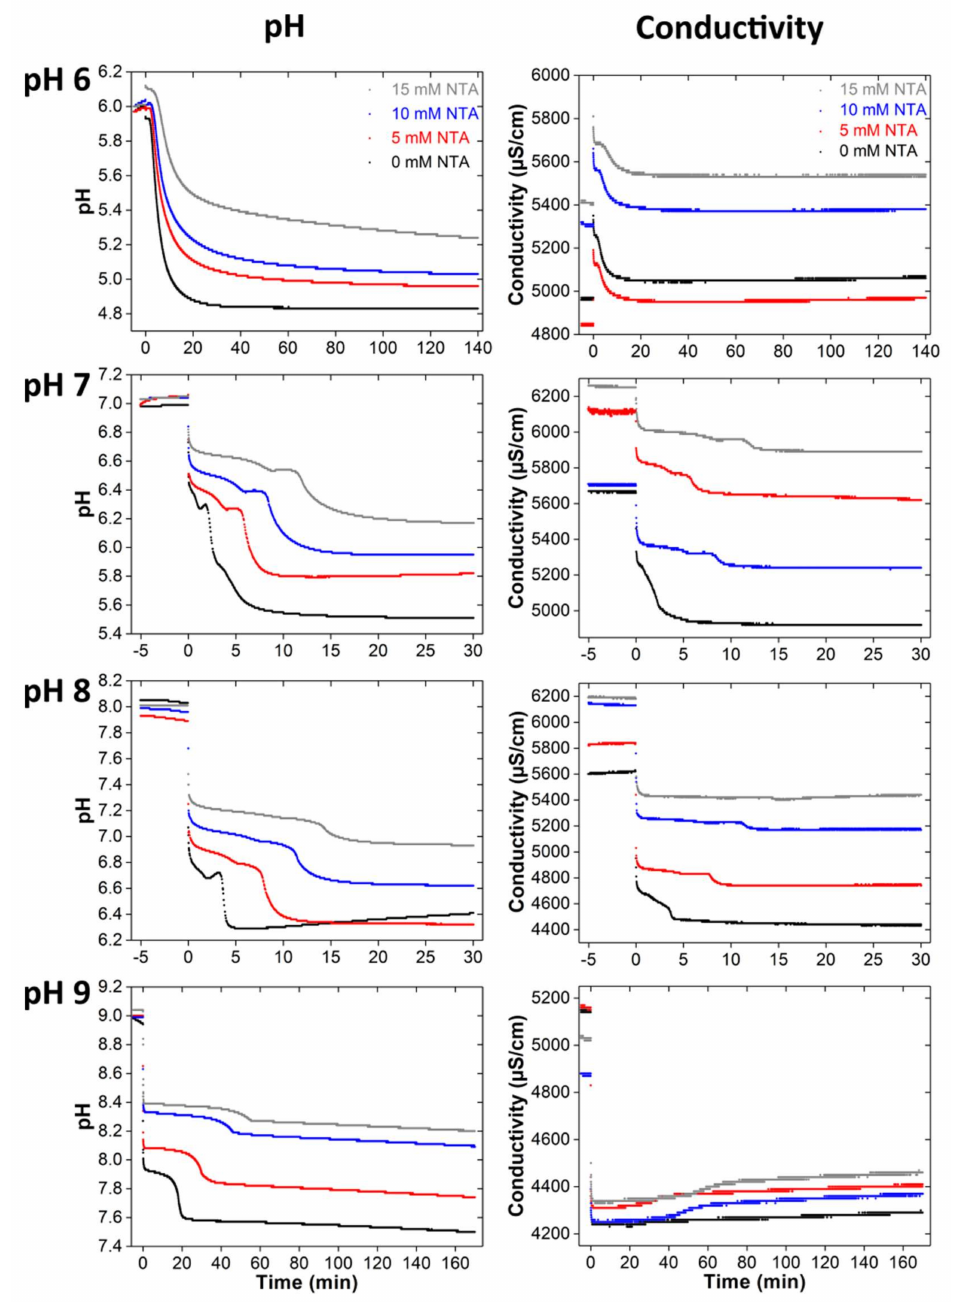
Figure 3. pH and conductivity data obtained from in situ measurements during mineralization with different NTA concentrations and starting pH. Note that the mineralization times are different: the end points (points after which no more changes in the data are observed) of the individual series of measurements were determined from longer measurements (data not shown). At the beginning of each measurement, the pH of the initial solution (40 mM calcium nitrate solution with 0, 5, 10, and 15 mM of NTA) was stirred and the pH and conductivity were recorded for 5 min. Then a 40 mM diammonium hydrogen phosphate solution was added and the mineralization experiment was started. This point is the “0” on the time